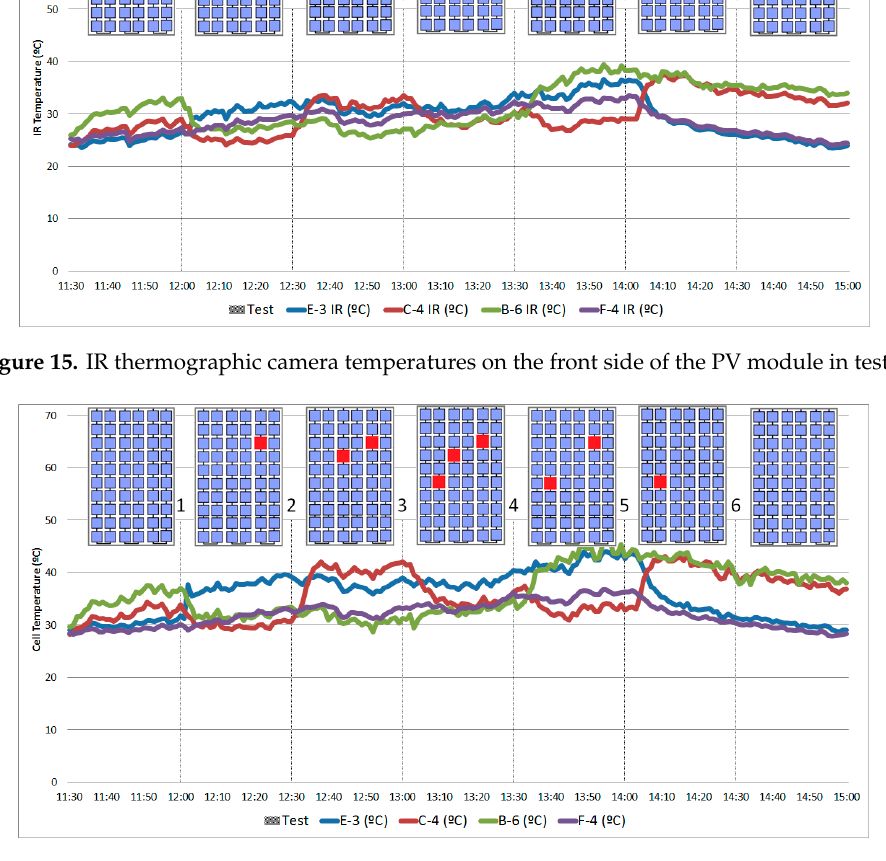
Figure 16. Thermocouple temperatures on the back side of the PV module in test 3.